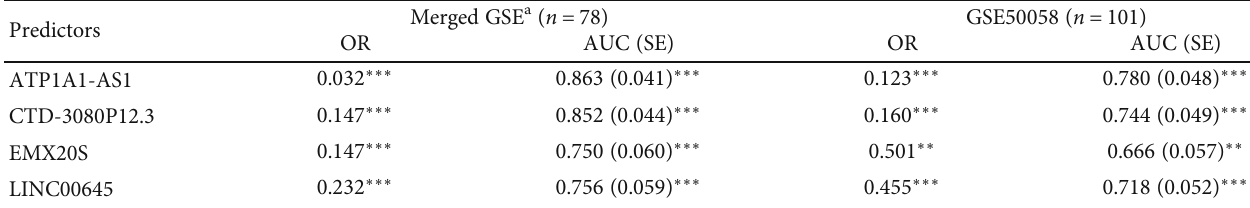
Table 3: Logistic regression analyses and ROC analyses of the 4 optimal lncRNAs.